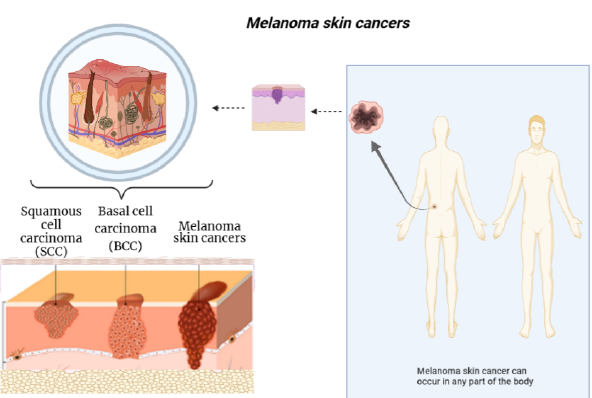
Figure 1. An overview of melanoma skin cancers. Figure created with